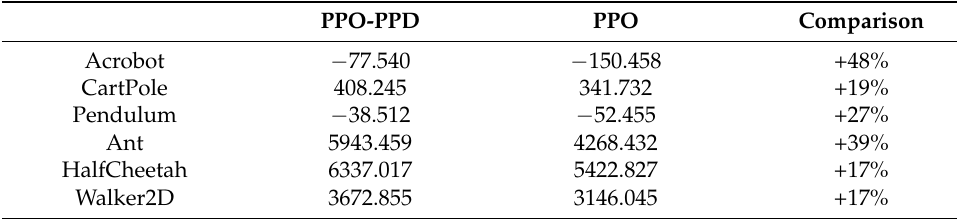
Table 3. The performance comparison between PPO-PPD and PPO.